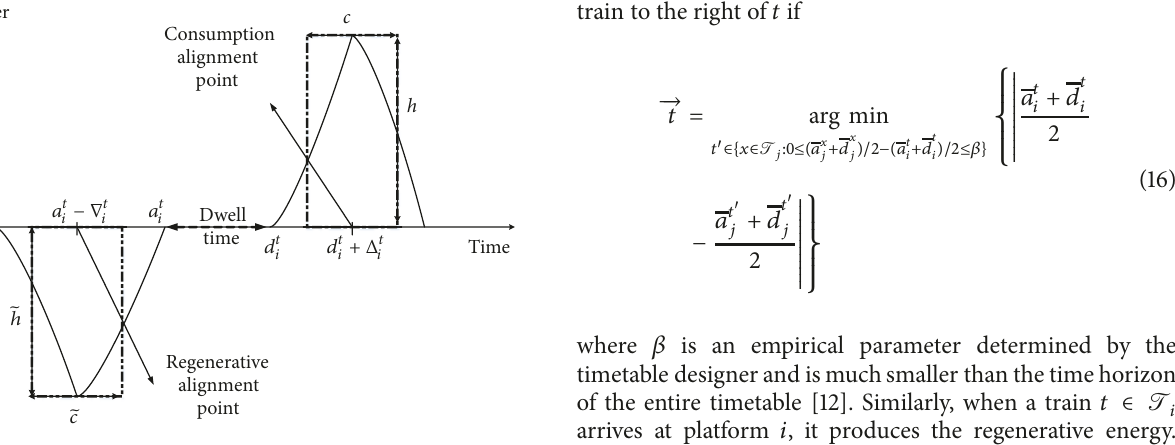
Figure 3: Use rectangles instead of energy consumption and regenerative